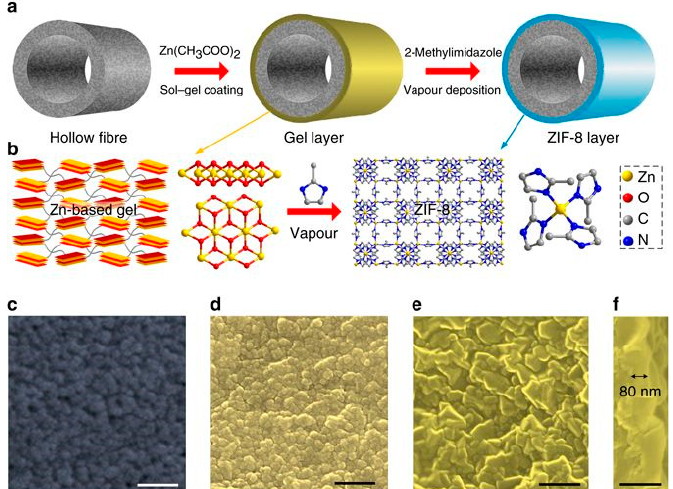
Figure 13. Gel–vapor deposition (GVD) fabrication of ultrathin ZIF-8 membrane. ( a ) Schematic of MOF membrane formation process. ( b ) Schematic illustration and chemical structure of Zn-based gel and crystalline structure of ZIF-8. Zn, O, C and N atoms are depicted in yellow , red , grey, and blue , respectively. H atoms are not presented for clarity. Top view SEM images of ( c ) the PVDF hollow fiber and ( d ) the Zn-based gel layer. SEM images of ( e ) top and ( f ) cross-sectional view of the ZIF-8 membrane prepared with sol concentration of 1U and coating time of 2 s. The images are colored for clarity. Scale bar , 200 nm (adapted with permission from ref.